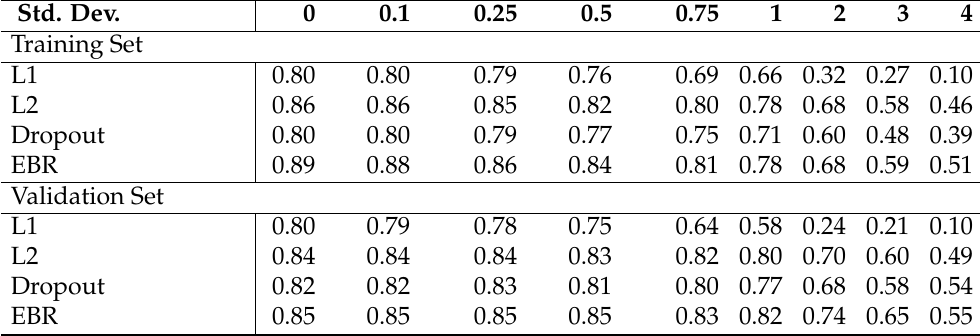
Table 1. Training and validation accuracy for Fashion-MNIST data with increasing noise for various regularization methods (EBR: evidence-based regularization). Std.